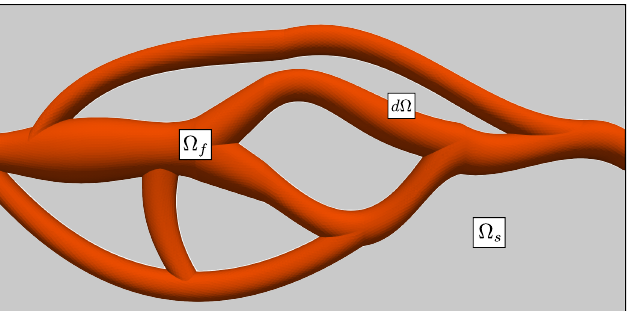
Figure 1. Definition of the current framework. The fluid domain and the solid domain are defined by Ω Ω Ω denotes the fluid-solid interface. s , respectively. d f and